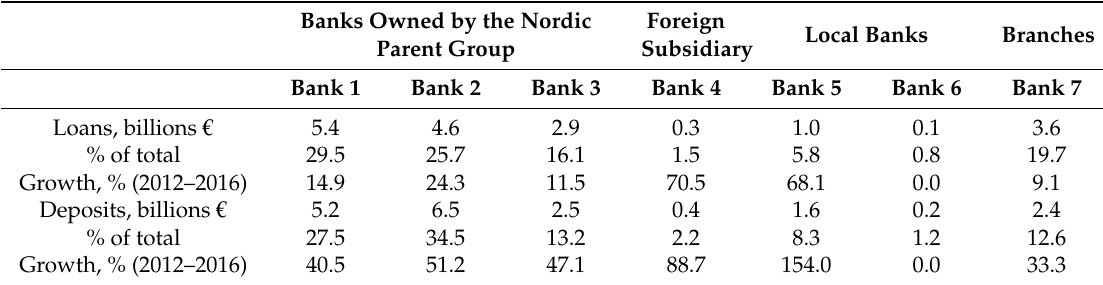
Deposits, billions